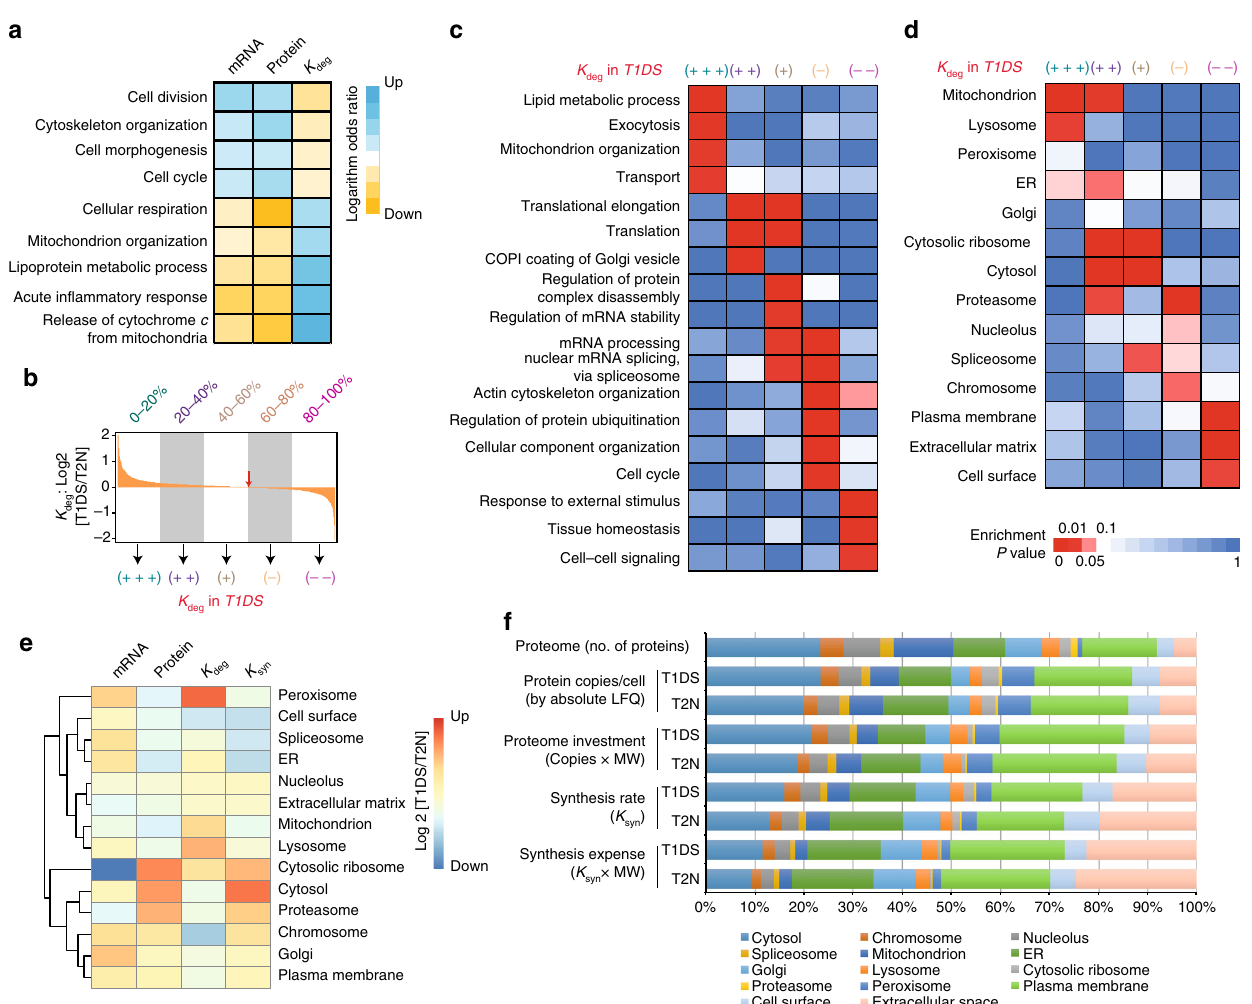
Fig. 5 Extent of protein degradation reveals organelle-related gradients in T21. a Selected signi fi cant, overlapping biological processes after GESA analysis at mRNA, protein, and K deg levels. The logarithm odds ratios (LOR) were visualized on a red – blue color scale, with blue color denoting LOR > 0 (i.e., T1DS gene products are under represented) and red denoting LOR < 0 (i.e., T1DS products are over-represented). b The fi ve classes of proteins based on K deg regulation extent. The red arrow denotes zero K deg regulation. c The ranked list of protein degradation regulation under T21 stress was divided into fi ve segments of proteins for which GO biological processes enriched in each segment were selected and displayed. d Cellular components annotation and enrichment analysis indicates the extent to which protein degradation forms an organelle-related gradient in T21. e The transcript, protein, protein degradation, and protein synthesis FC of all the proteins annotated in each organelle were averaged for hierarchical clustering analysis. f Comparing the number of proteins, absolute protein copies, protein investment, and synthesis expense for different organelles in T1DS and T2N, respectively. K deg